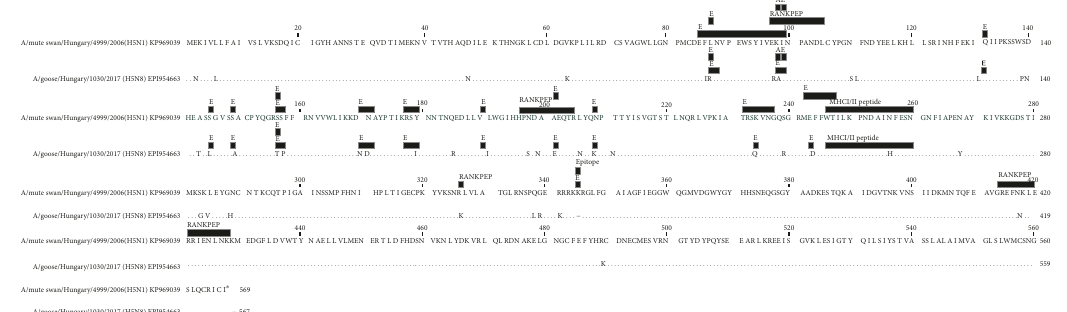
Figure 1: Alignment of A/mute swan/Hungary/4999/2006 (H5N1) and A/goose/Hungary/1030/2017 (H5N8) HA amino acid sequences. Identical residues are marked by dots. The sites of antigenic relevance (abbreviation: “ A ” ), the predicted epitopes (abbreviation: “ E ” ), the predicted MHC epitopes by RANKPEP, and the MHCI/II epitope identi fi ed for AIV H5 are marked by shaded boxes according to published reports [23 – 25,